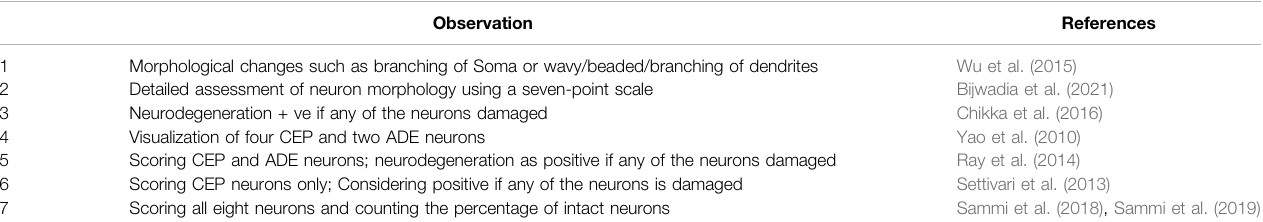
TABLE 3 | Methodologies adopted for evaluation of dopaminergic neurons.